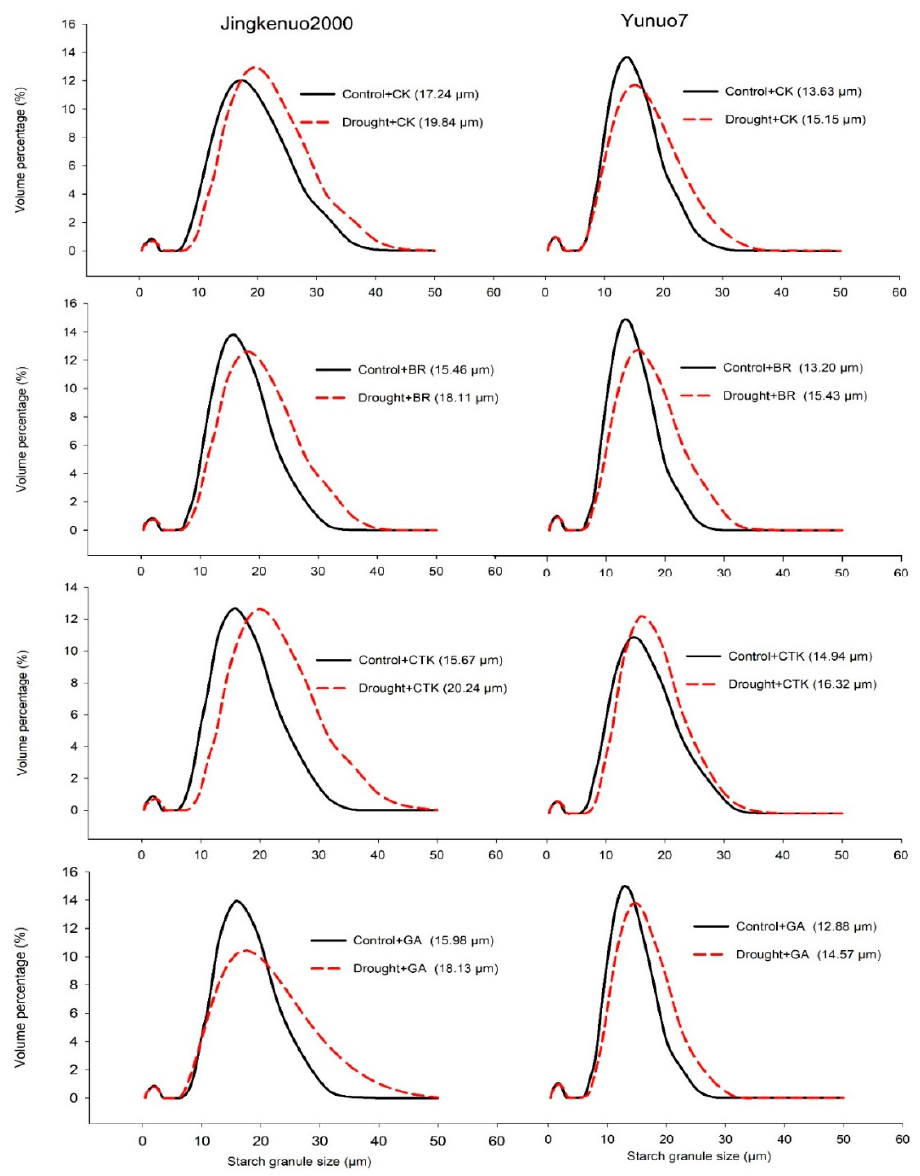
Figure 4. The size distribution of grain starch granules with exogenous hormones under control and drought conditions in waxy maize. CK, water; CTK, cytokinin; BR, brassinolide; GA, gibberellic acid. Data in the bracket are the average starch granule